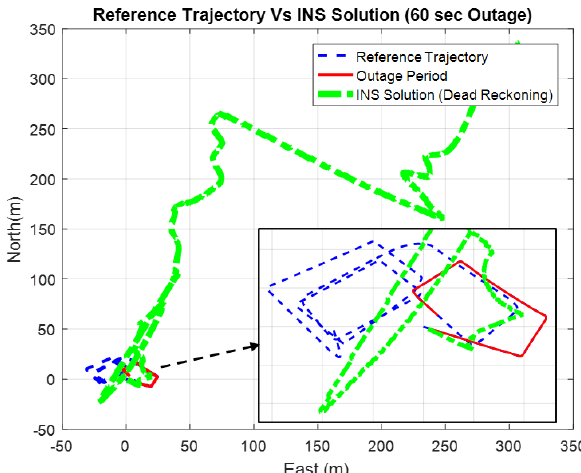
Figure 11. The solution of the INS -Stand alone system during GNSS signal outage is compared to the reference trajectory Figure 9. Air-Odo velocity estimation compared to the reference showing the massive drift happened during this outage period. velocity, and the red circles showing that this version of Air- Odo with additional weight can't sense the lower velocities Also, Figure 12 and Table 1 show the errors in the north and east profile. direction during this GNSS outage period. The results prove the massive drift happened during this period which reached hundreds of meters.